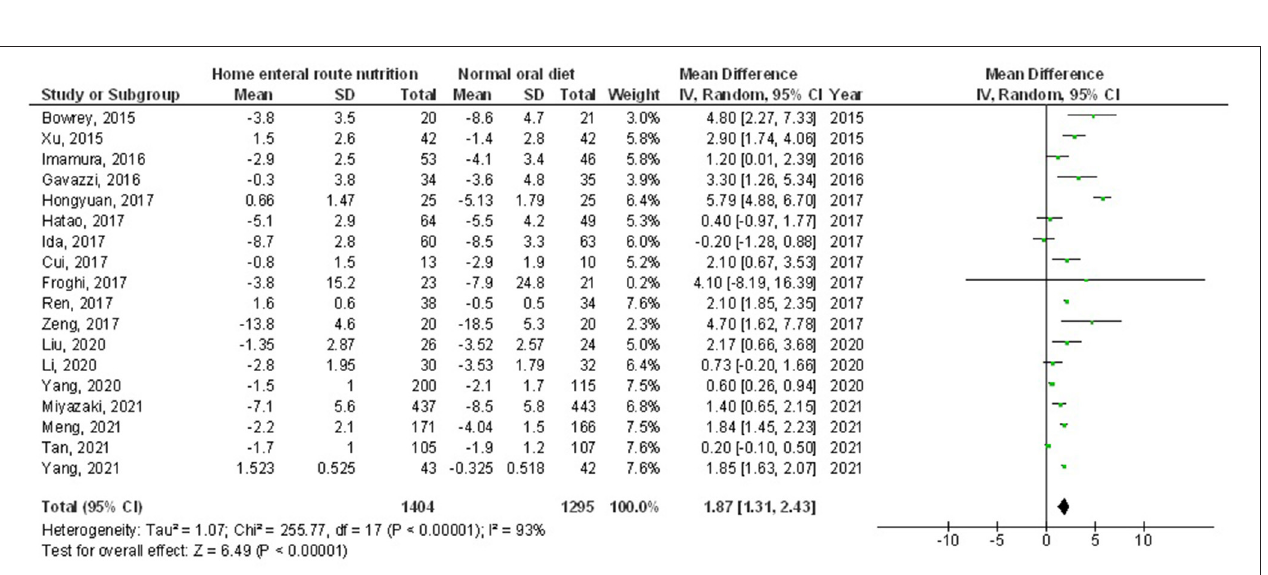
FIGURE 2 | A forest plot of the quality of life in subjects with upper gastrointestinal cancer resection with the home enteral nutritional support compared to the normal oral diet.